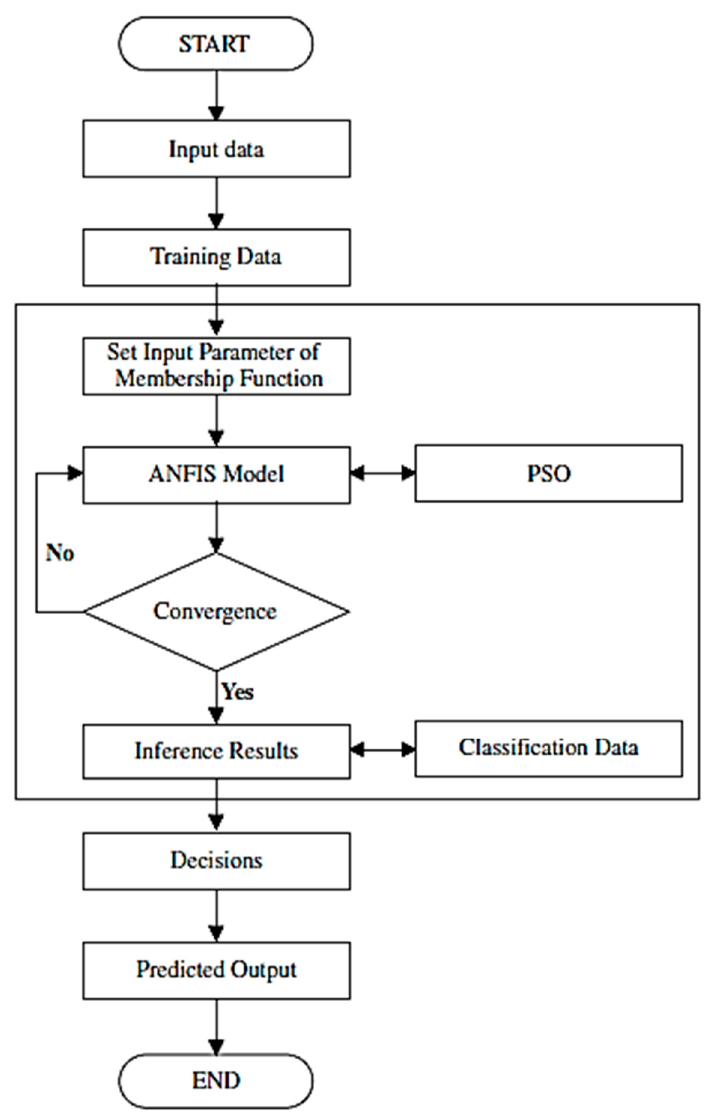
Figure 2. Diagram of the optimized ANFIS structure using the particle swarm optimization (PSO) algorithm (ANFIS-PSO).